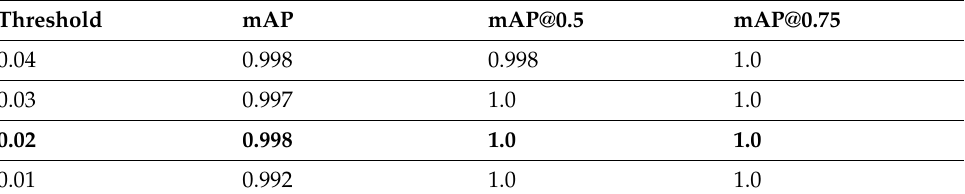
Table 3. The performance comparison by setting different box regression-variance thresholds to select pseudo-boxes for box regression using Mask R-CNN [17] with ResNet-101 [19] backbone on 10% label data.